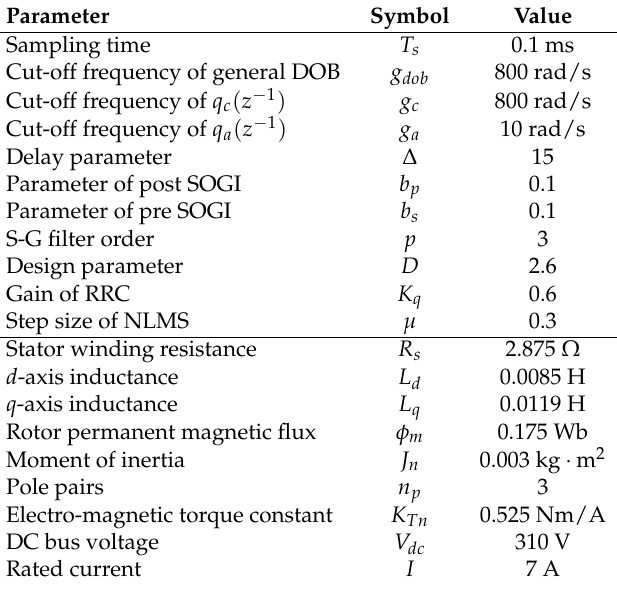
Table 2. Simulation